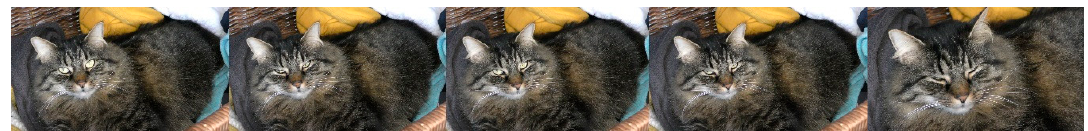
Figure 1. Still images captured of the cat slow blink sequence, starting from a neutral face followed by a half blink then eye narrowing moving towards eye closure.